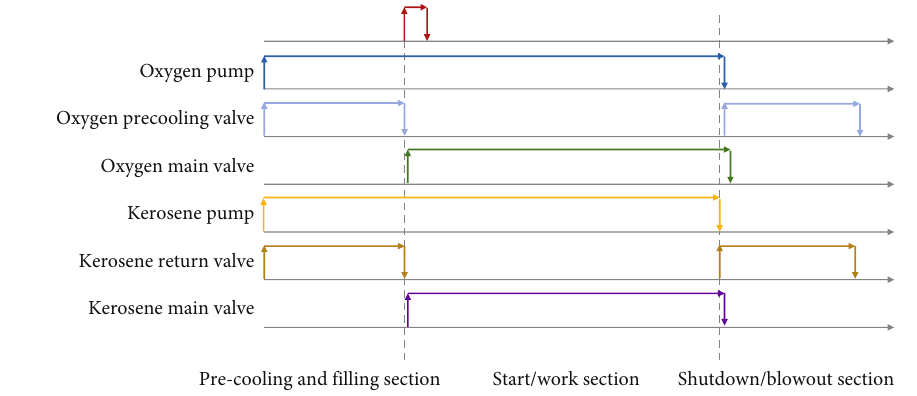
Figure 4: Working sequence of the test